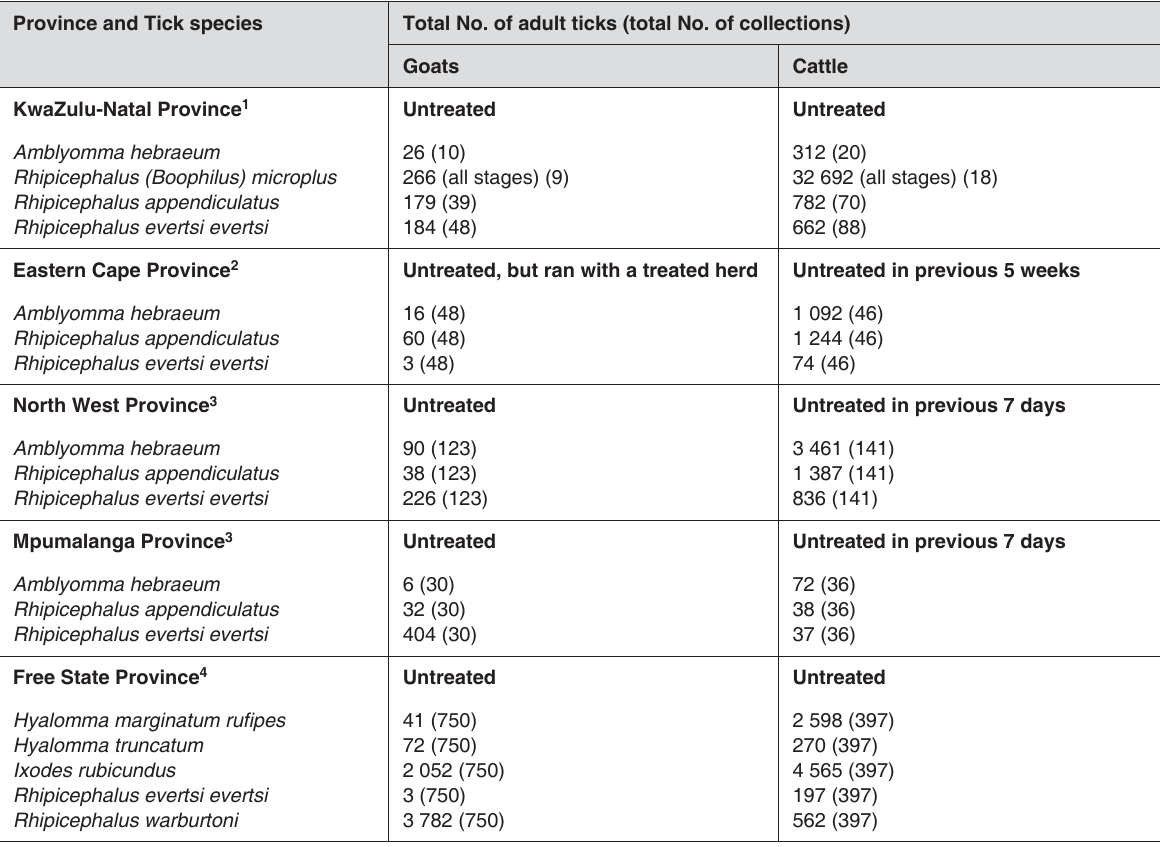
TABLE 1 Numbers of ticks collected in previous surveys from goats and cattle examined at the same localities in various provinces of South Africa Province and Tick species Total No. of adult ticks (total No. of collections) Goats